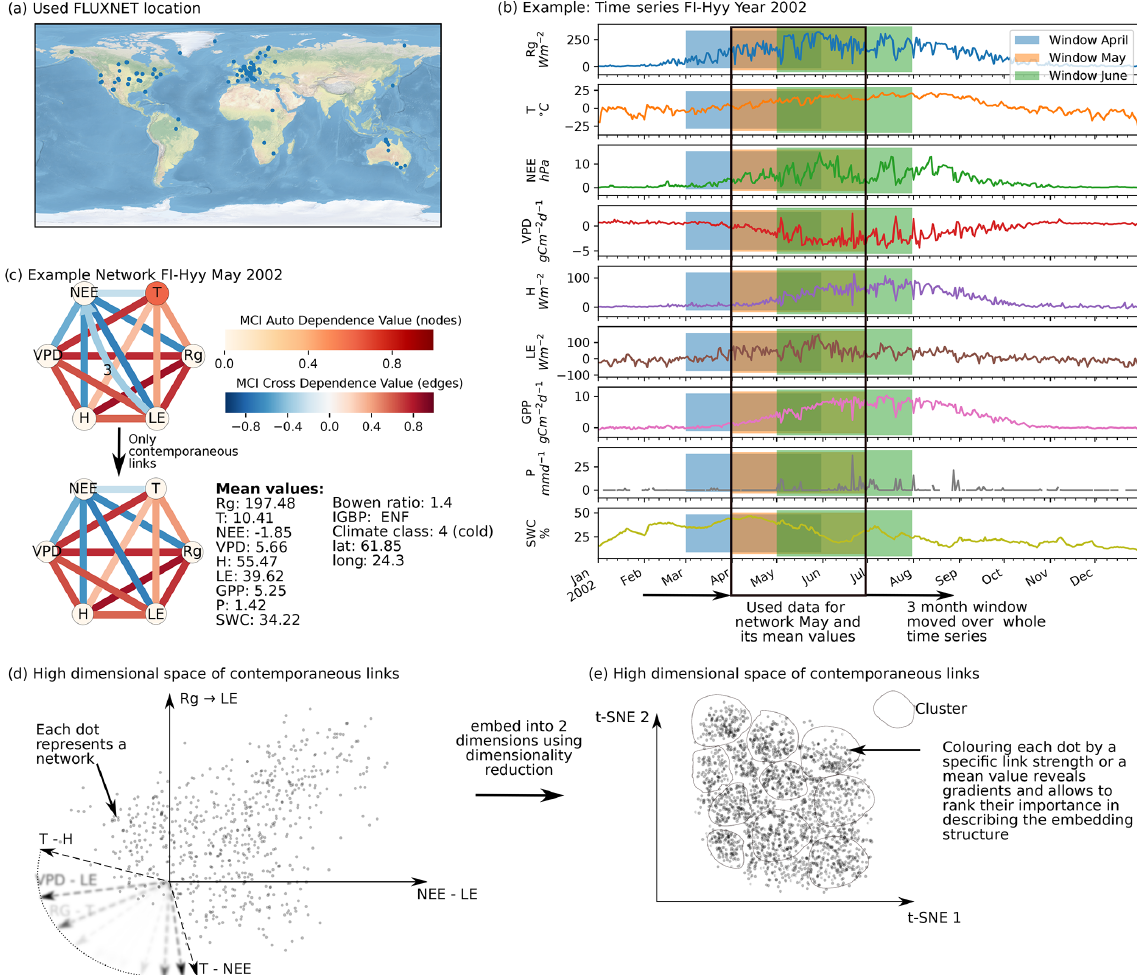
Figure 1. Schematic representation of the workflow. (a) Eddy covariance data from the FLUXNET database are selected (119 sites). (b) For each site we used the time series of global radiation R g , air temperature T , vapour pressure deficit VPD, net ecosystem exchange NEE, sensible heat H , latent heat LE , gross primary productivity GPP, precipitation P , and soil water content SWC. Networks are estimated in 3-month moving windows using R g , T , NEE, VPD, LE , and H . (c) An example interaction network for FI-Hyy (Hyytiälä) in May 2002. Contemporaneous links are given by straight (undirected) edges; lagged links are given by curved arrows with a number indicating the time lag. The strongest and most persistent links are contemporaneous. Thus we limit our analysis to those links. (d) Each 3-month network can be interpreted as an observation in a 15-dimensional space (each contemporaneous link is one dimension). (e) Dimensionality reduction projects all interaction networks into a two-dimensional space preserving its local-neighbourhood structure. Here any subsequent analysis and interpretation will be